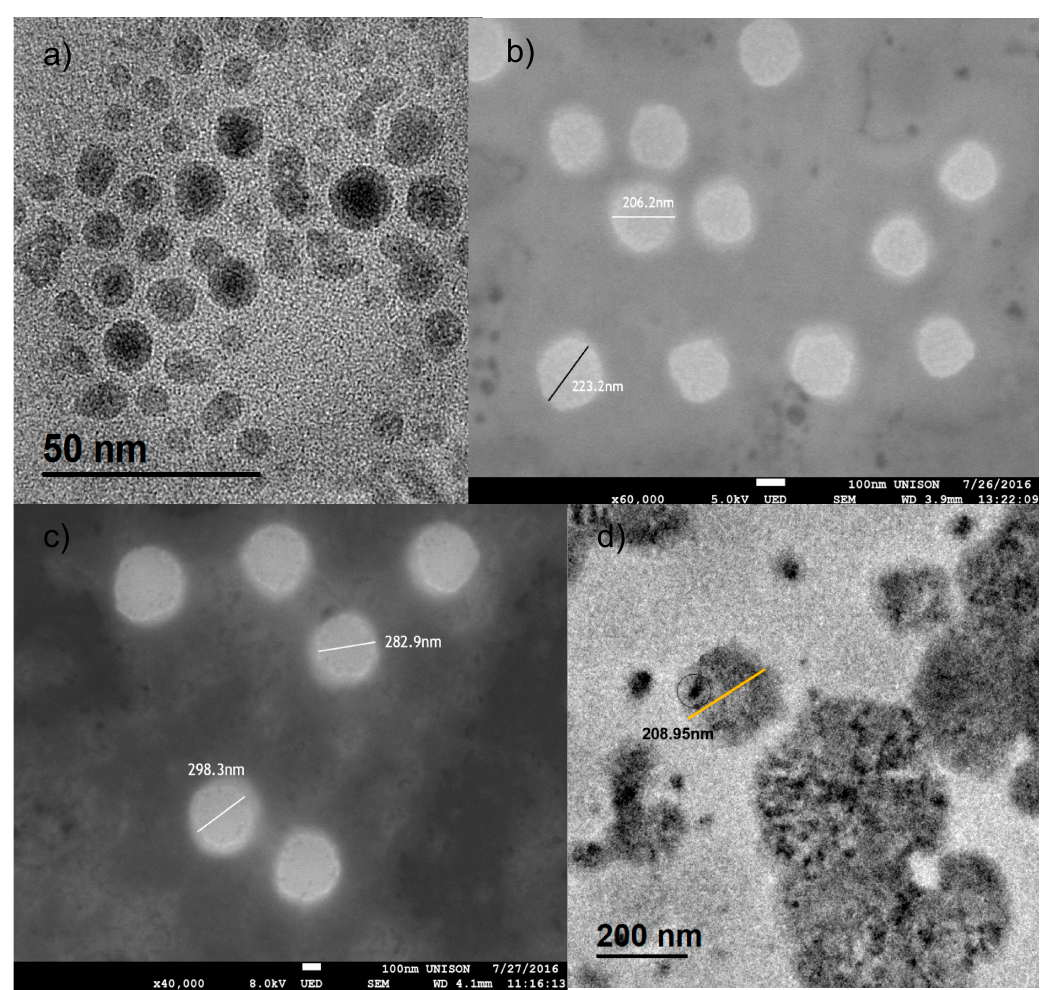
Figure 1. TEM and SEM micrographs of the iron carbide@iron oxide nanoparticles and the iron